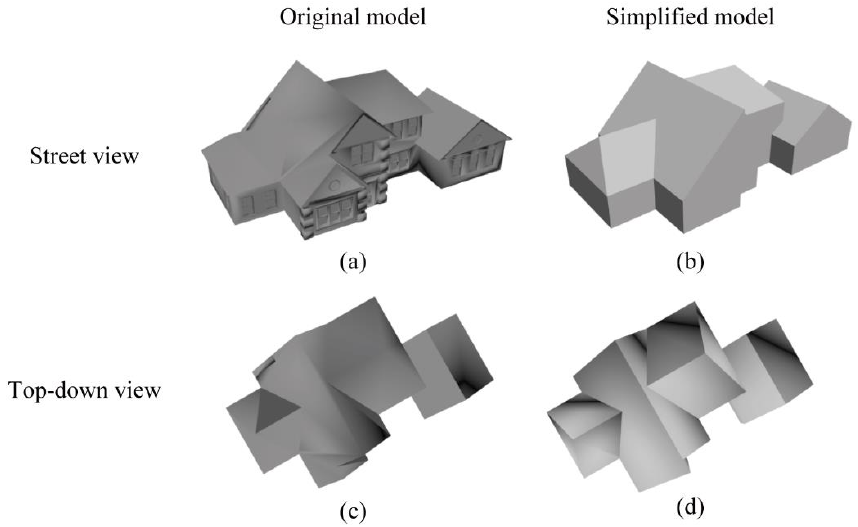
Figure 7. Simplification of 3D building with sloped roofs: (a) original model in street view; (b) simplified model in street view; (c) original model in top-down view; and (d) simplified model in top-down view.